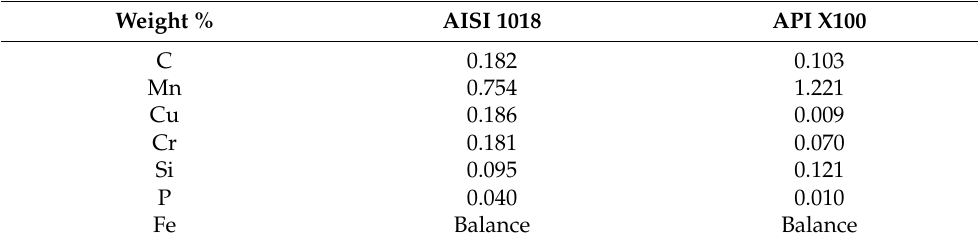
Table 1. Monolithic Ni-P Coating Vickers Hardness Measurement